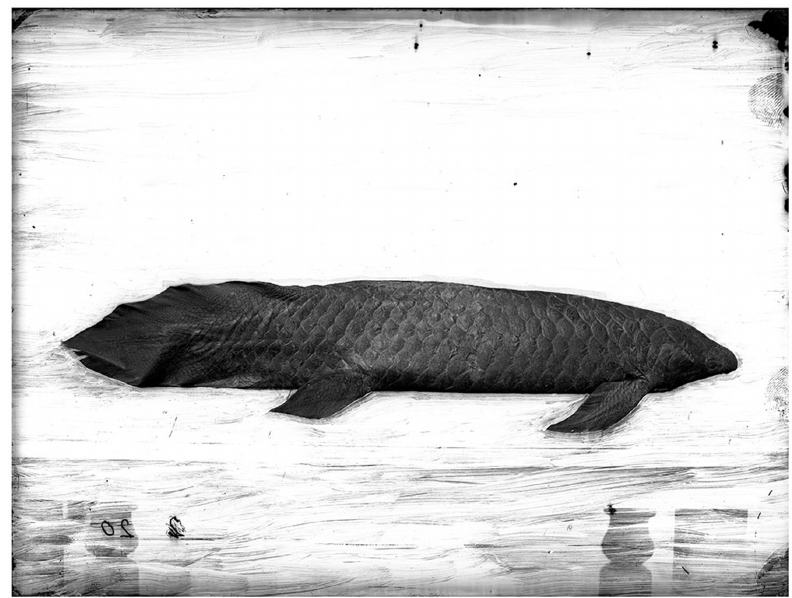
Figure 1: This figure and the next ones are four views of Ceratodus forsteri , 1870. The fish was destroyed in the dissection process, so that these photographs are the only remaining records of the first Ceratodus forsteri specimen. Photographer Henry Barnes. Reproduction courtesy of Australian Museum Archives;